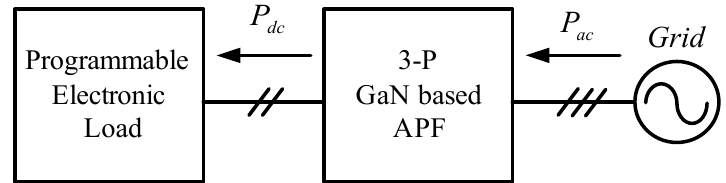
Figure 25. The system block diagram of the efficiency tests.